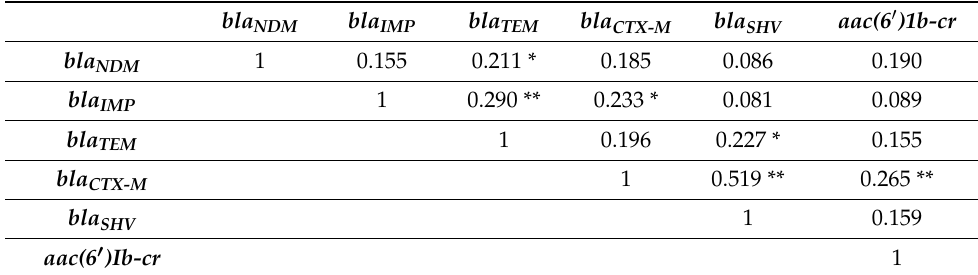
Table 9. Correlation matrix (r 2 ) between the different